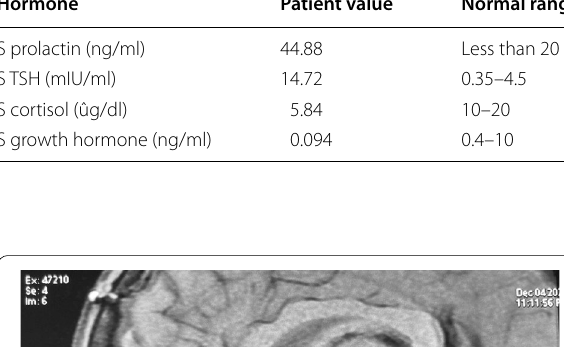
Fig. 11 H&E stain showing Rathke’s cleft cyst wall lining. a Cuboidal to columnar epithelial lining of the cyst wall. b Empty space within the cyst